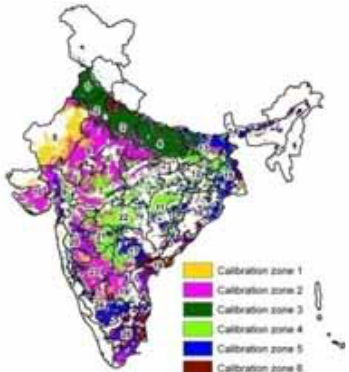
Figure 1. Study area with different calibration zones. Meteorological subdivisions under the present study: Punjab(1), Haryana Chandigarh Delhi (2), West Uttar Pradesh (3), East Uttar Pradesh (4), West Rajasthan (5), East Rajasthan (6), West